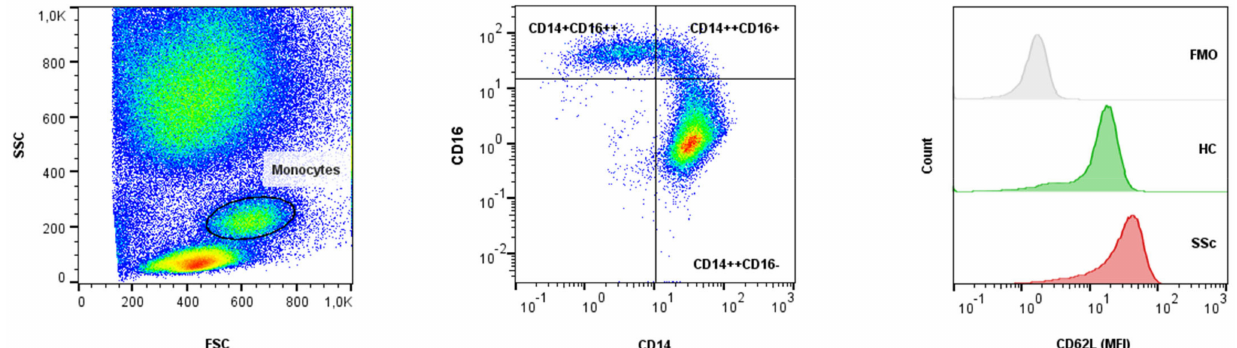
Figure 2. Gating of the monocytes based on forward and side scatter parameters, with the definition of the monocyte subsets, based on CD14 and CD16 surface molecules, as classical (CD14++CD16 − ), intermediate (CD14++CD16+), and non-classical (CD14+CD16++) [4]. The CD62L MFI shift to higher values is seen in the SSc monocytes compared to the HC. Negative control is represented as FMO. FMO—fluorescence minus one; FSC—forward scatter; HC—healthy controls; MFI—median fluorescence intensity; SSc—systemic sclerosis; SSC—side